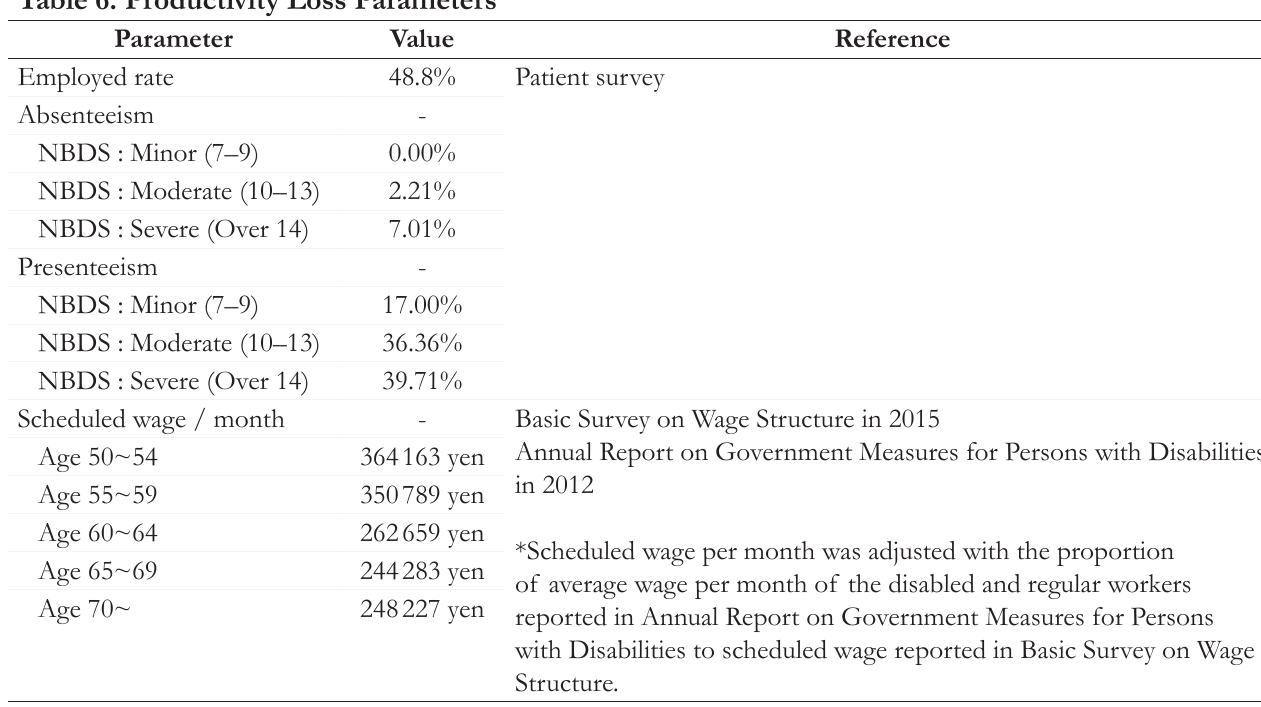
Table 6. Productivity Loss Parameters